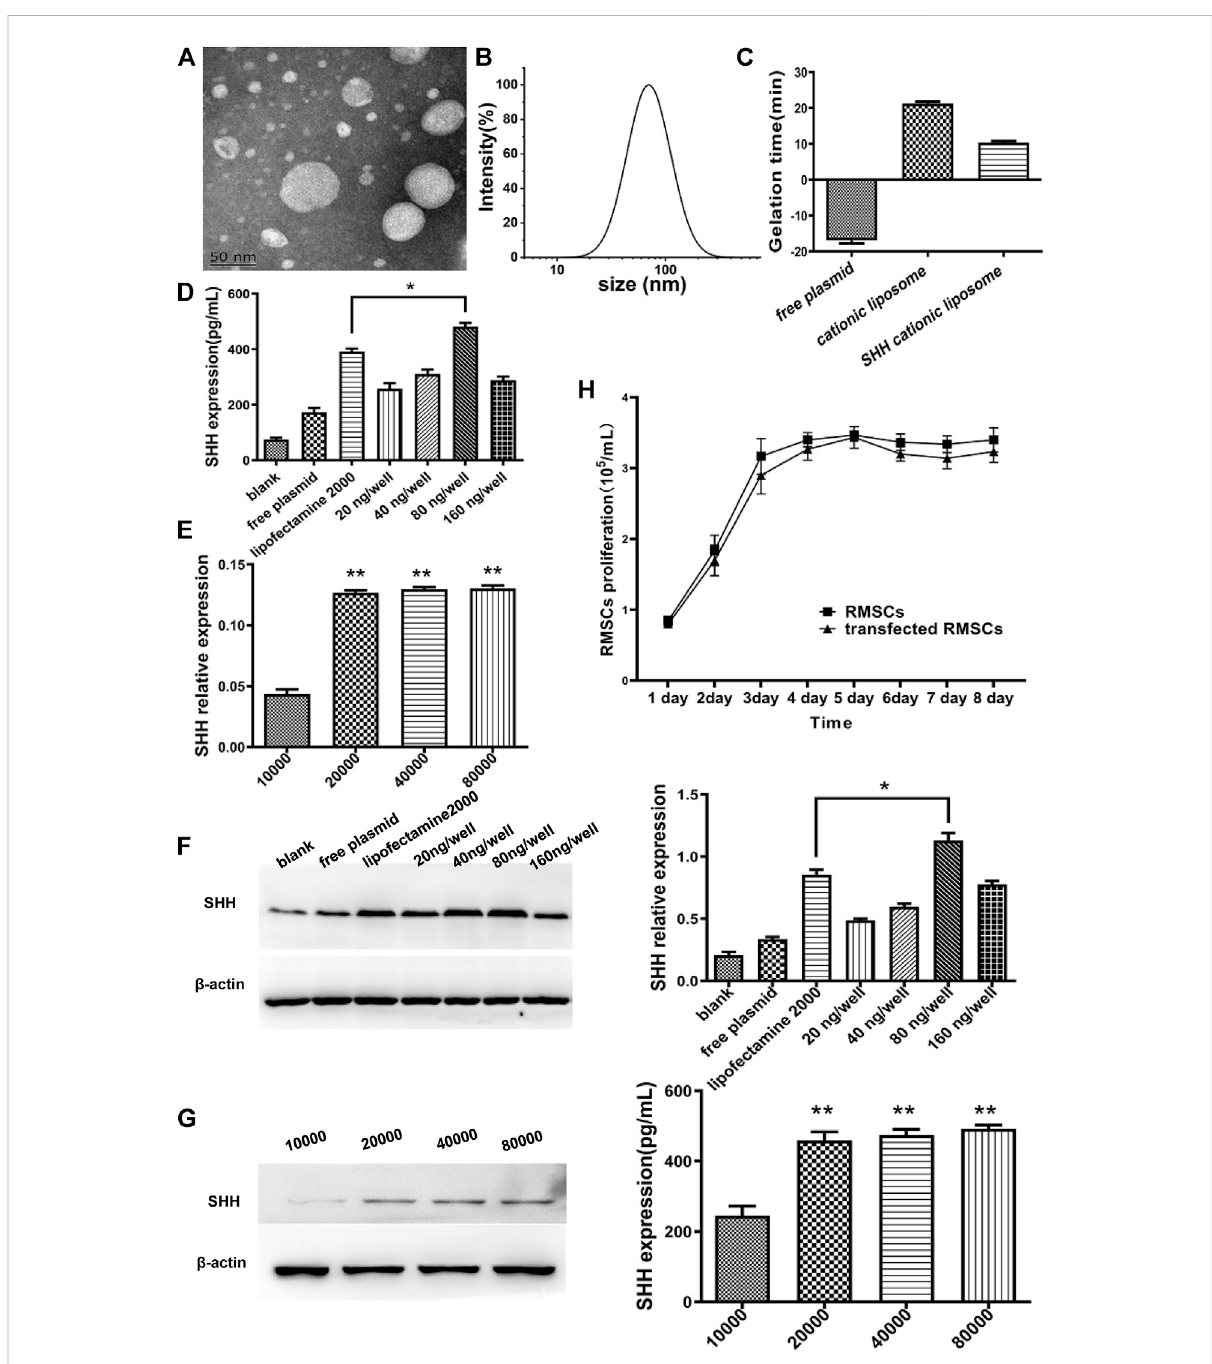
FIGURE 2 Characterization of cationic liposomes and screening for optimal SHH transfection conditions. (A) TEM of cationic liposomes; (B) The particle size distribution of cationic liposomes. (C) Zeta potential of plasmids, cationic liposomes, and SHH-cationic liposomes. (D) and (F) The SHH with different concentration of plasmids by ELISA and Western blotting (WB). The SHH expression of 80 ng per well was signi fi cantly higher than other groupsandobtained betterexpressionthanlipofectamine2000(*, p < 0.05). (E) and (G) TheSHHexpressionwithdifferentcelldensitybyELISA and WB. The best expression is in the condition of 80,000 cells (**, p < 0.01), and both 2000 cells and 4,000 cells were higher than 10,000 (**, p < 0.01). (H) The proliferation rate of RMSCs after transfection of the SHH gene from 1 to 8